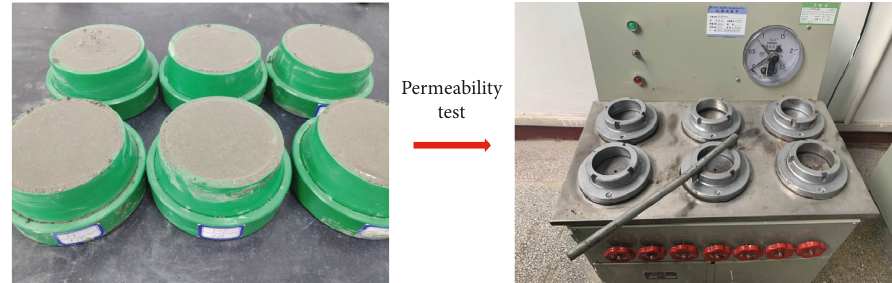
Figure 7: SS-15 mortar penetrator permeability